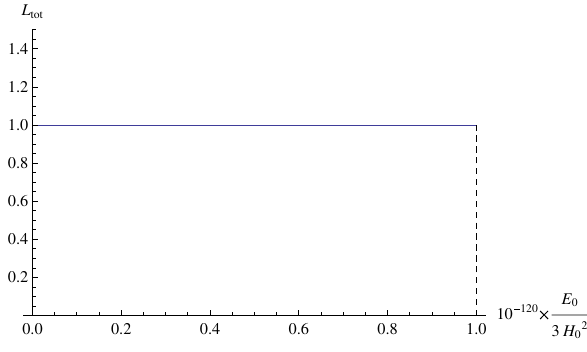
0.0 Fig. 16 Diagram of PDF for E 0 obtained as an intersection of the 3 H 2 0 likelihood function. Two planes of intersection likelihood function are H 0 = 68 . 82 and (cid:5) m , 0 = 0 . 3009. The planes of intersection are constructed from the best fitting value of the model parameters. We from the interval ( 0 , 10 120 ) . Note that the assume the value of E 0 3 H 2 0 values of the likelihood function are not sensitive to changing of E 0 3 H 2